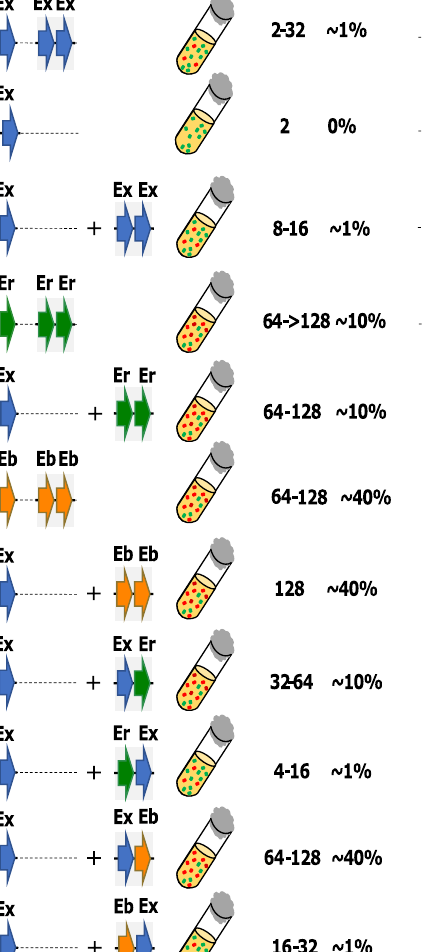
Fig. 4 | Heteroresistance capabilities of phoP - phoQ hybrid and mgrB com- plementedmutants. Thehybridcomplementmutantswerecreatedbycombining phoP and phoQ geneseitherof E.xiangfangensis RBK-17-0394-1(Ex), E.bugandensis RBG-17-0246-1 (Eb), and E. roggenkampii RPB-17-0516-2 (Er). Plasmids harboring phoP - phoQ hybrids were transferred to Ex394 Δ phoPQ . Complementation of the phoQ from the isolates exhibiting higher colistin heteroresistance i.e., Eb and Er to